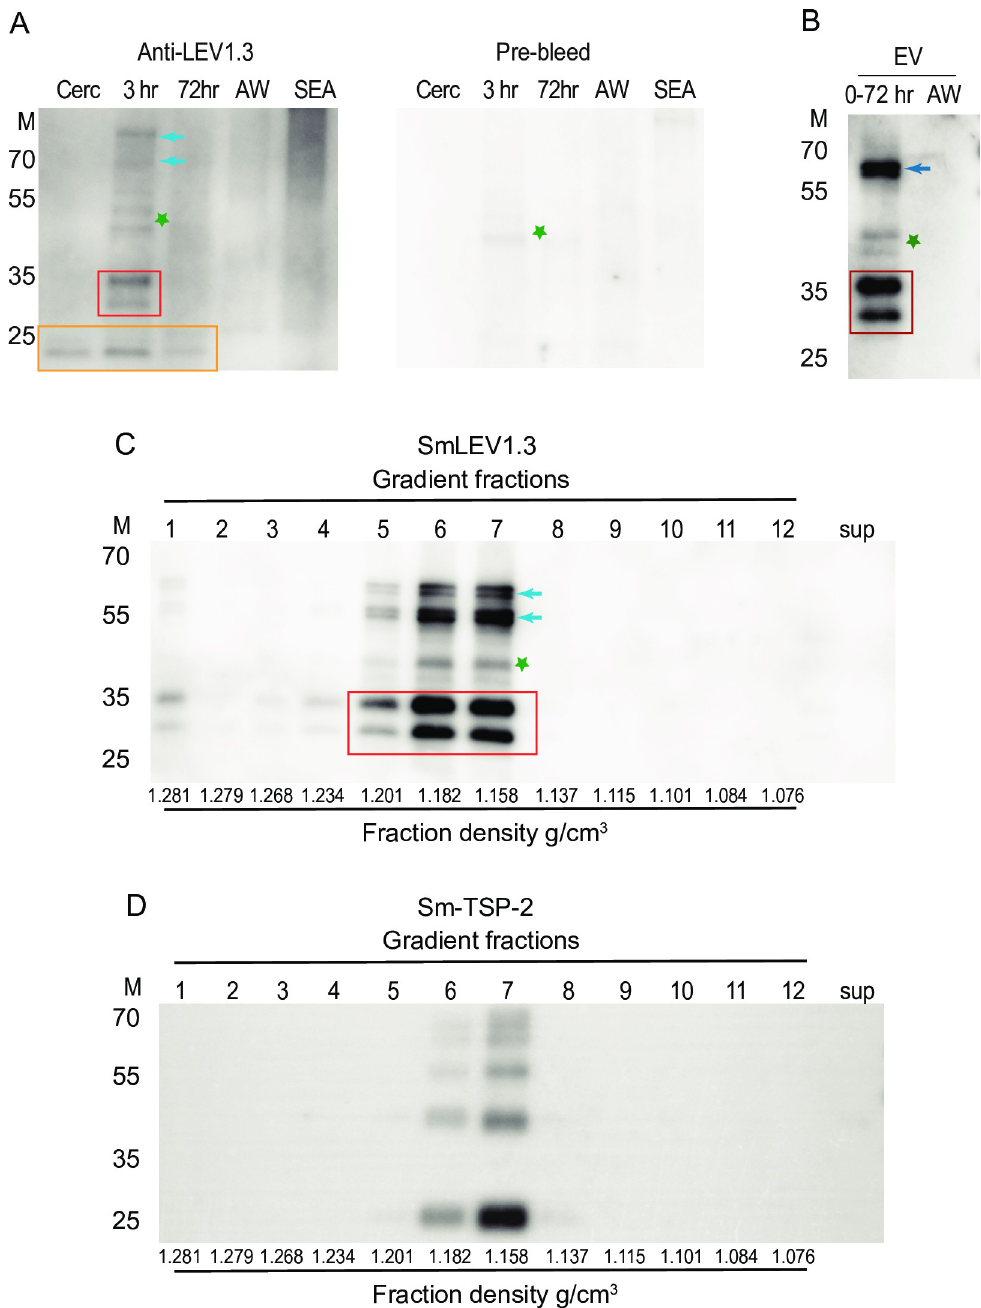
Fig 3. SmLEV1 is enriched in schistosomula EVs with densities spanning 1.16 to 1.2 g/cm 3 . (A) Parasite extracts (1.5 μ g) from different life stages were probed with anti-SmLEV1.3 or rabbit pre-bleeds (primary Ab 1:2,000). Cerc– Cercariae, 3 h– 3 hour schistosomula, 72 h– 72 hour schistosomula, AW–mixed sex adult worm, SEA–Soluble egg antigen. (B) Anti-SmLEV1.3 probing EVs (100 ng) from 0–72 h schistosomula (0–72 h) or mixed-sex adult worms (AW). (C) EVs obtained from 0–72 h cultivated schistosomula were separated via density gradient prior to anti-SmLEV1.3 or (D) anti- SmTSP-2 probing. Fraction numbers are indicated above the blot; the respective densities in g/cm 3 are shown below the plot. In all figures, the red box indicates the major 28–35 kDa proteins, blue arrows indicate additional larger proteins, the orange box indicates slightly smaller ~24 kDa reactive proteins. Green star indicates a non-specific immunoreactive protein. For probing EVs, primary pAb was used at 1:20,000 dilution. For all figures, secondary anti-rabbit HRP conjugated antibody was used at 1:10,000. M = protein standard, mass in kilo Daltons.